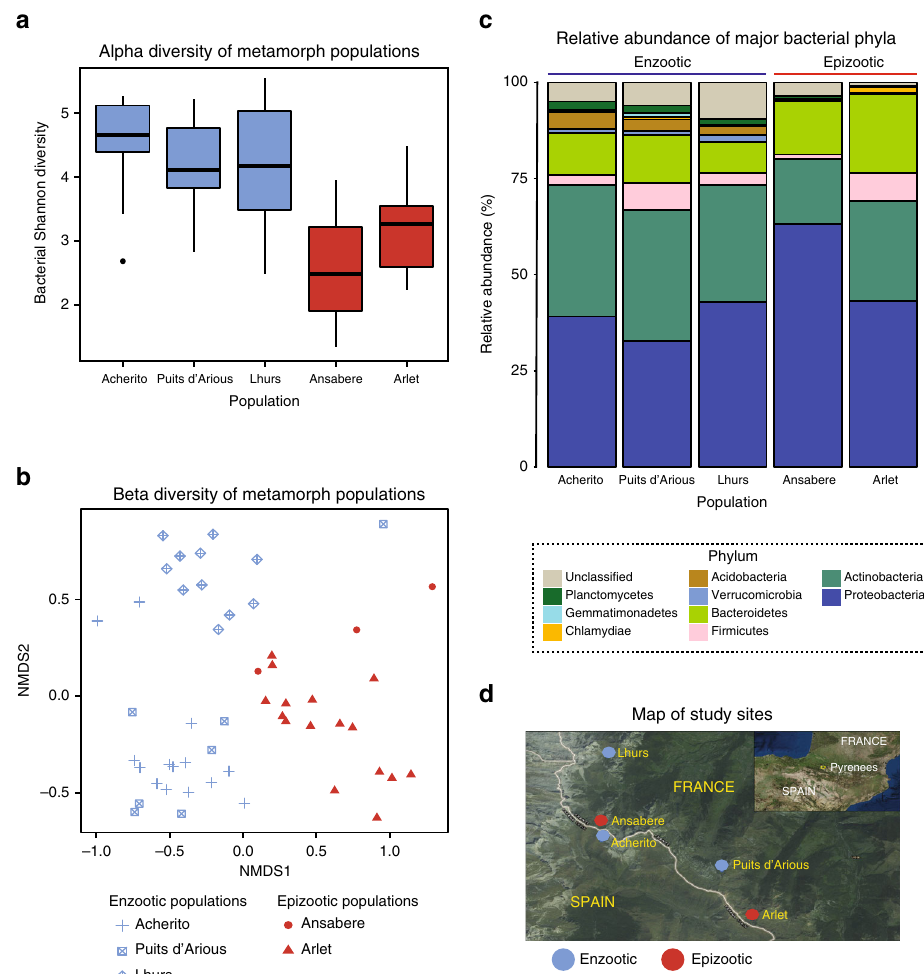
Fig. 3 Bacterial community pro fi les of Alytes obstetricans metamorph skin from enzootic and epizootic populations. a Shannon diversity of metamorph populations. Epizootic populations are in red and enzootic populations are blue. Boxes represent 25 and 75 percentile; the horizontal line is the median and whiskers are maximum and minimum values. b NMDS plot based on Bray − Curtis distances displaying beta diversity of enzootic and epizootic populations. c Stacked bar chart of abundant bacterial phyla for each metamorph population. d Map showing location of enzootic and epizootic populations. Map generated using ArcGIS version 10.0 (http://www.esri.com/software/arcgis) with the World Imagery Basemap. Source: Esri, DigitalGlobe, GeoEye, Earthstar, Geographics, CNES/Airbus DS, USDA, USGS, AeroGRID, IGN, the GIS User Community. Sample sizes were: Enzootic = 32 (Acherito = 14, Lhurs